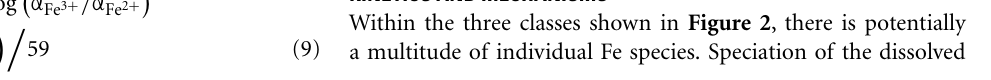
is thermodynamically feasible for various Fe 2